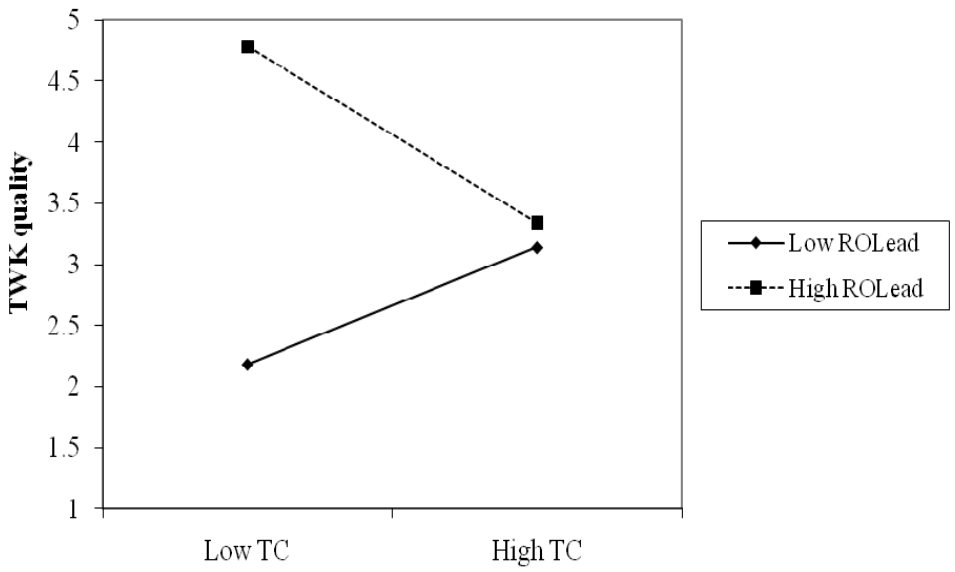
Figure 2. Interaction effects of task conflict (TC) and relations oriented leadership style (ROLead) on teamwork quality (TWK